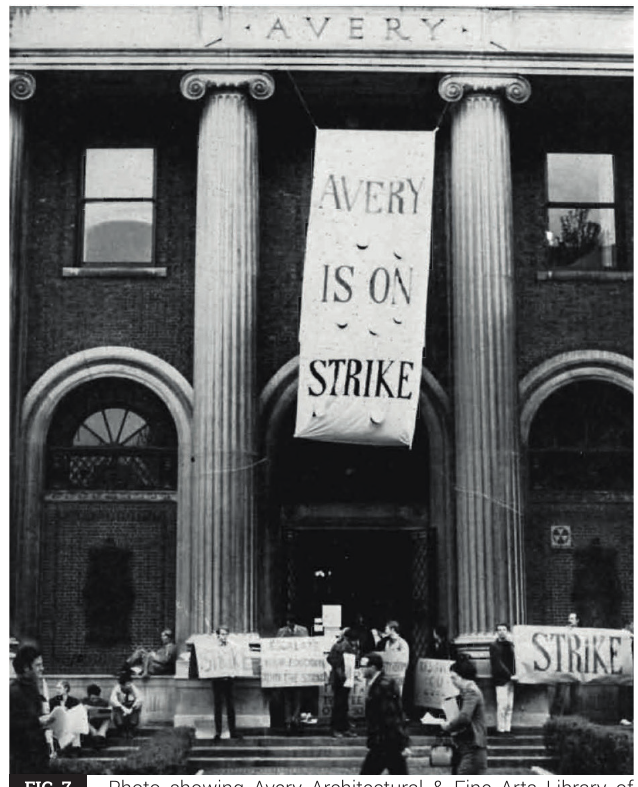
Photo showing Avery Architectural & Fine Arts Library of Columbia University on strike (Source: George Keller, “Six weeks that Shook Morningside,” Columbia College Today 15, no. 3 (1968):